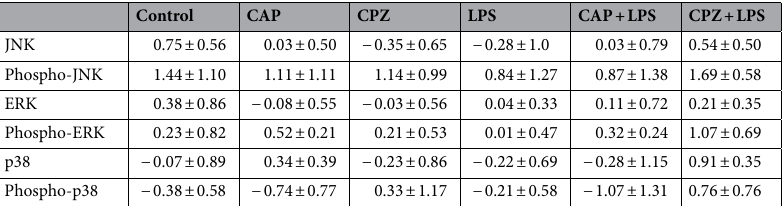
Table 2. Intracellular pathway signaling by phosphorylation of JNK, ERK and p38 after TRPV1 stimulation or inhibition in hiPSC-derived cardiomyocytes. Results of optical density measurements. Optical density (OD) of unphosphorylated and phosphorylated enzymes after background signal subtraction as measured by ELISA. The background signal was measured in wells treated with the respective reagent but not exposed to the respective antibody. Results are derived from three independent experiments consisting of two to three biological replicates per experiment. As the mean + 2SD method showed all signals within background levels, no statistical comparison test was applied to the data. LPS, 1 µg/mL, 6 h, CAP, 10 µM, 20 min, CPZ, 100 µM, 20 min. CAP—capsaicin; CPZ—capsazepine; LPS—lipopolysaccharides.